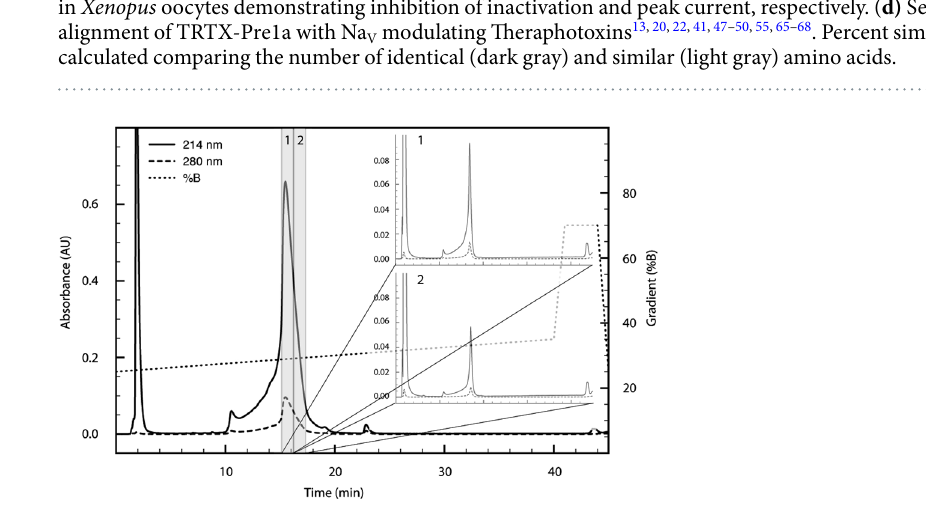
Figure 2. Pre1a shows conformational flexibility under RP-HPLC conditions. Analytical RP-HPLC of pure synthetic Pre1a shows the presence of multiple conformers in and acetonitrile/water mixture at room temperature. Insets 1 and 2, demonstrate identical elution profiles for reinjection of two fractions (highlighted and numbered) taken from the major peak, discounting the presence of